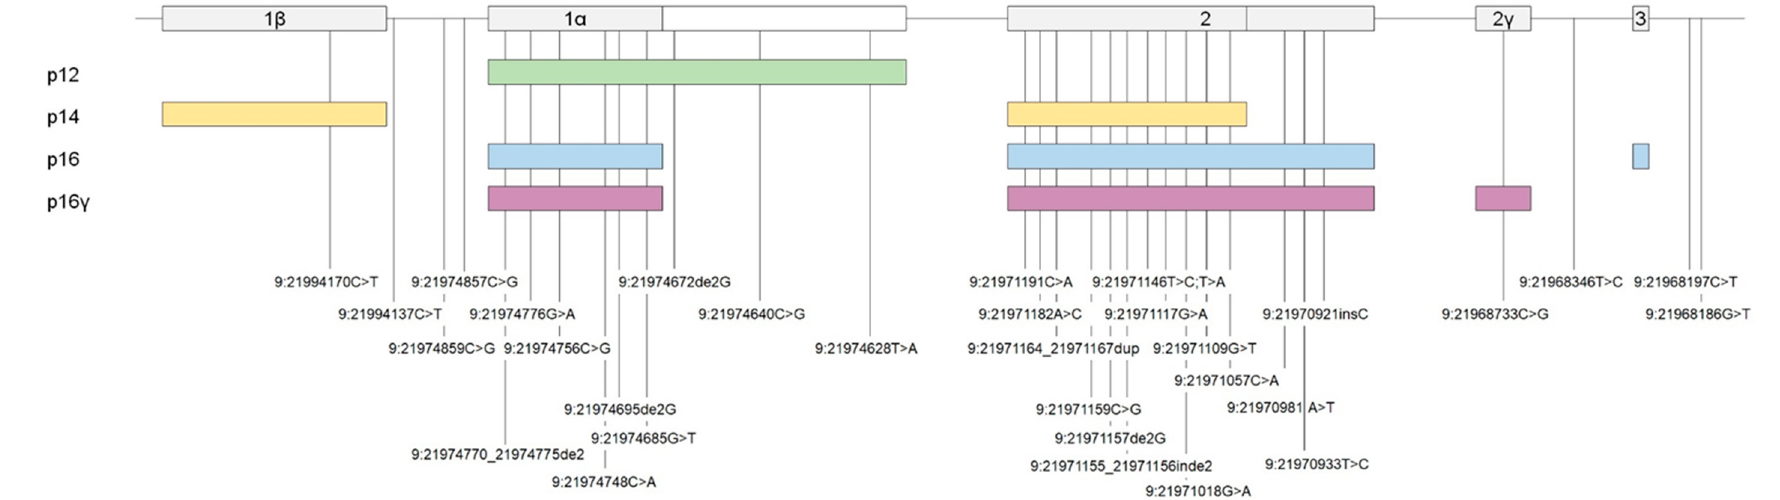
Figure 4. CDKN2A variants mapped over the genic structure and over the 4 coded isoforms. Exons are in scale and are represented as grey rectangles on the top. Introns are not in scale and they are represented by a black line through the genic sequence. The CDKN2A isoforms (i.e., p12, p14, p16 and p16 γ ) are shown on the bottom as colored rectangles. The DNA variants are name according the hg19 Human Genome Assembly.